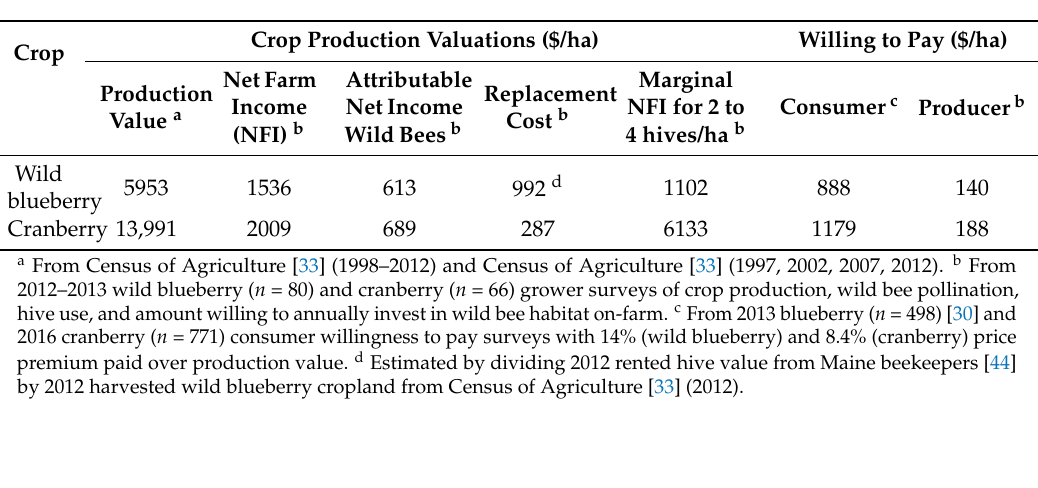
Maine, USA, wild blueberry and Massachusetts, USA, cranberry pollination valuation